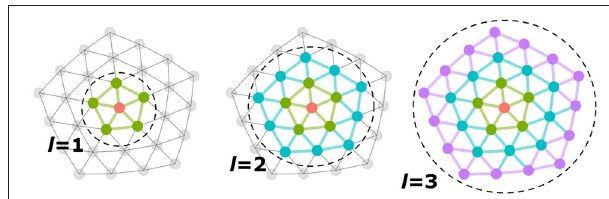
FIGURE 1 | Each layer, l , implicitly aggregates more distant neighborhood signals into a node update. The first layer aggregates information over immediately adjacent neighbors, while the second, third, etc. layers incorporate signals from increasingly larger